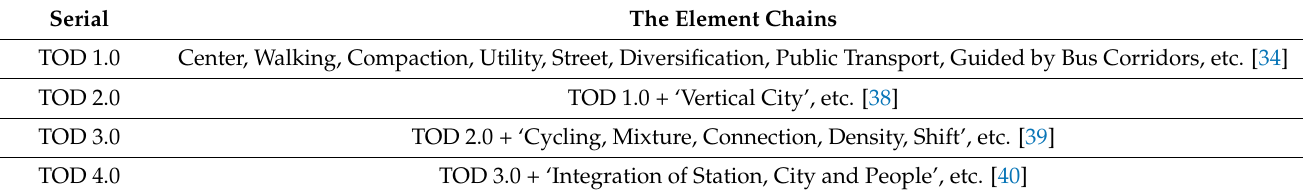
Table 4. The representative element chains of TOD 1.0 to 4.0 are based on the review.